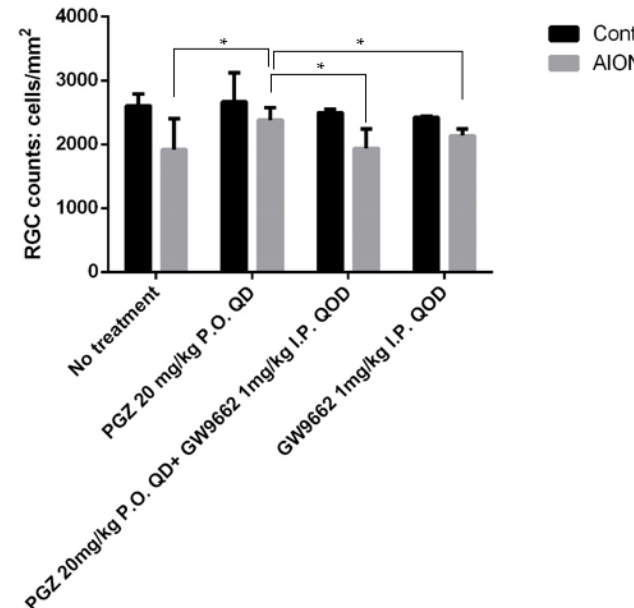
Figure 7. Brn3A + RGCs in non-diabetic mice. Bar graph showed average Brn3A + cell counts 4 weeks after AION induction in non-diabetic mice without treatment (oral DMSO only), non-diabetic mice treated with oral (PO) PGZ 20 mg/kg in 0.1% DMSO every day for 4 weeks, oral PGZ 20 mg/kg in 0.1% DMSO every day+ intraperitoneal (IP) injection of GW9662 (PPAR- γ inhibitor) 1 mg/kg every other day for 4 weeks, and intraperitoneal injection of GW9662 (PPAR- γ inhibitor) 1 mg/kg every other day for 4 weeks, respectively (* p < 0.05).